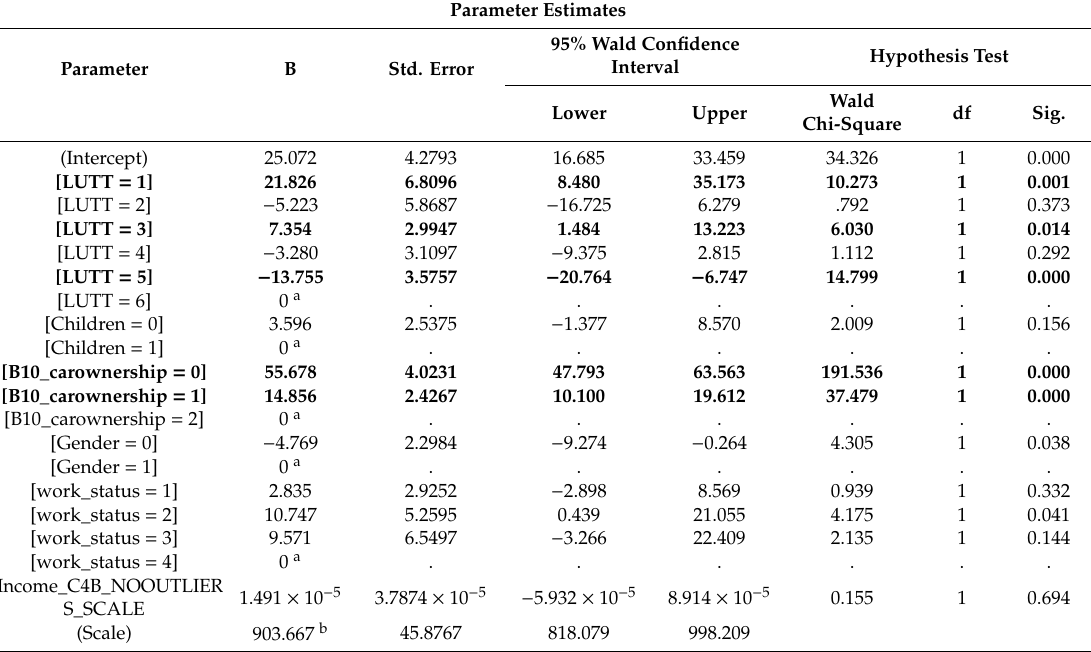
Table A7. E ff ects of Each Independent Variable in the Regression Model, with Statistically Significant Factors in Bold Text.